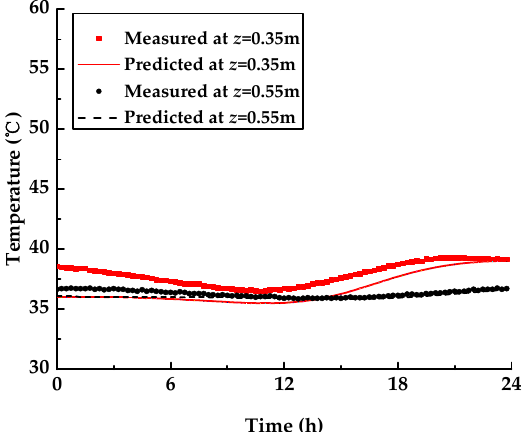
Figure 6. Measured and predicted temperature at z = 0.065 m and z = 0.09 m on 24 August.